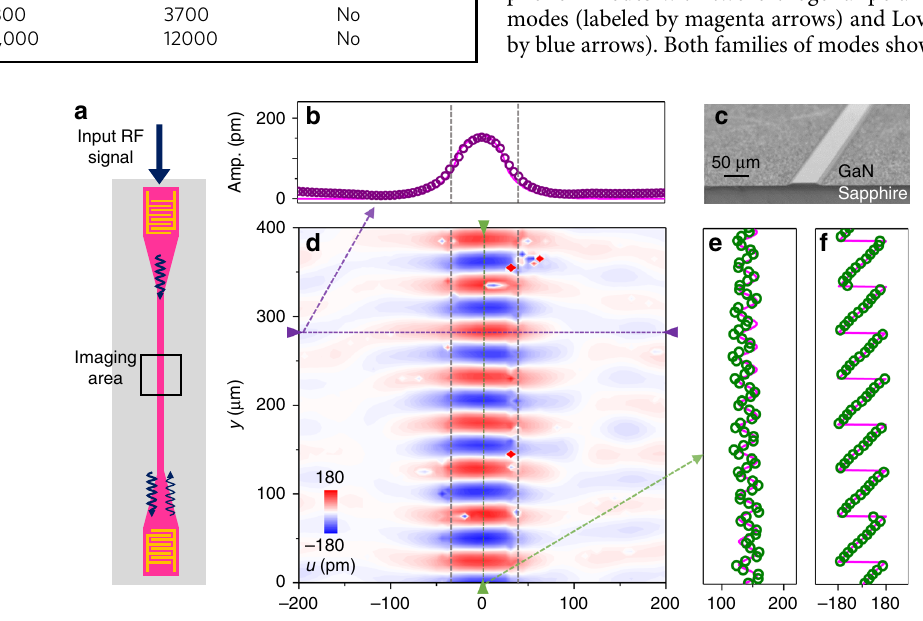
Fig. 2 Characterization of phononic waveguide and identi fi cation of a traveling Rayleigh-like mode. a The measurement scheme. c An scanning electron microscope (SEM) image of a phononic waveguide. b , d – f , The out-of-plane ( z -direction) displacement of a traveling Rayleigh-like mode. The data are measured by sending RF signal at 102 MHz into the IDT and scanning the vibrometer focal point in an area of 400 μ m × 400 μ m as illustrated in a . The reconstructed image of instant displacement is shown in d . The amplitude or phase at cross-sections of the two-dimensional scan are plotted in b , e , and f and taken at correspondingly colored lines in d . The magenta line in b represents the simulated displacement amplitude cross the waveguide, and the magenta lines in e and f are fi tted to traveling acoustic wave with weak re fl ection (10% re fl